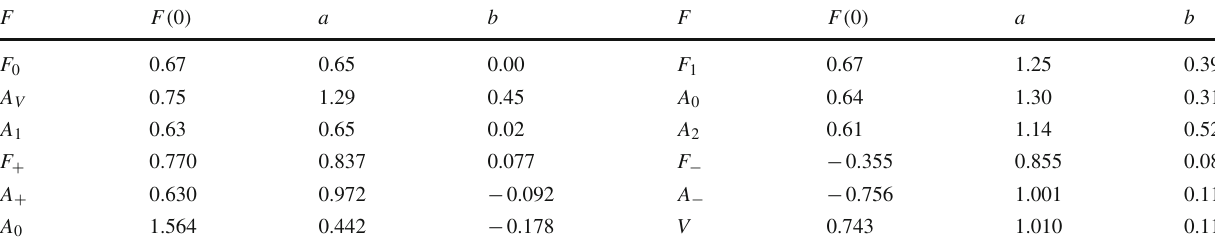
Table 2 The values of the parameters F ( 0 ) , a and b in the form factors of B → D ( ∗ ) [75] and B s → D ( ∗ ) s [76]